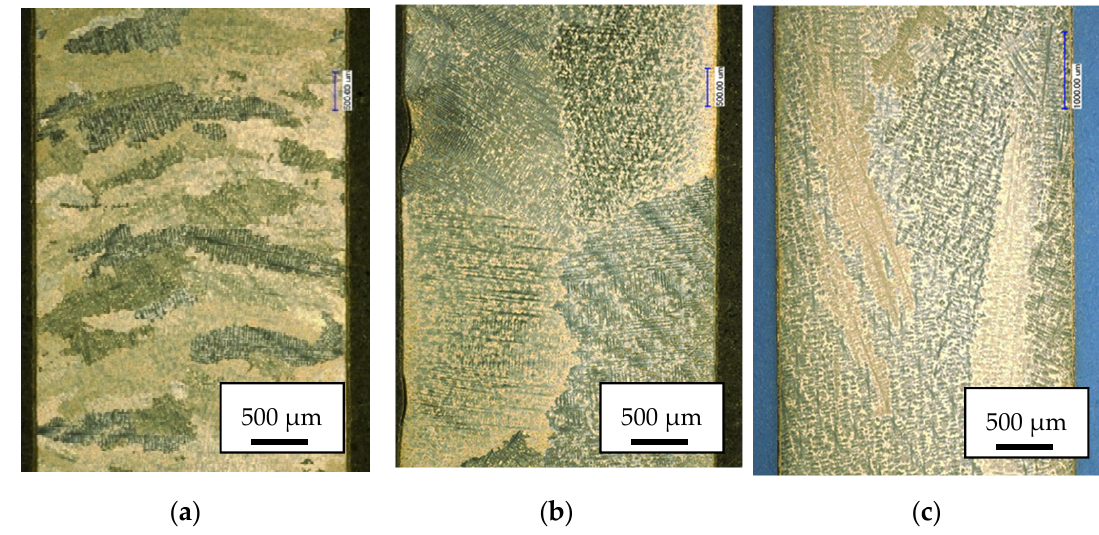
Figure 3. Microscopic structure of the MAR 247 nickel superalloy: ( a ) fine grain, ( b ) coarse grain and ( c ) column grain observed by using light optical microscope.